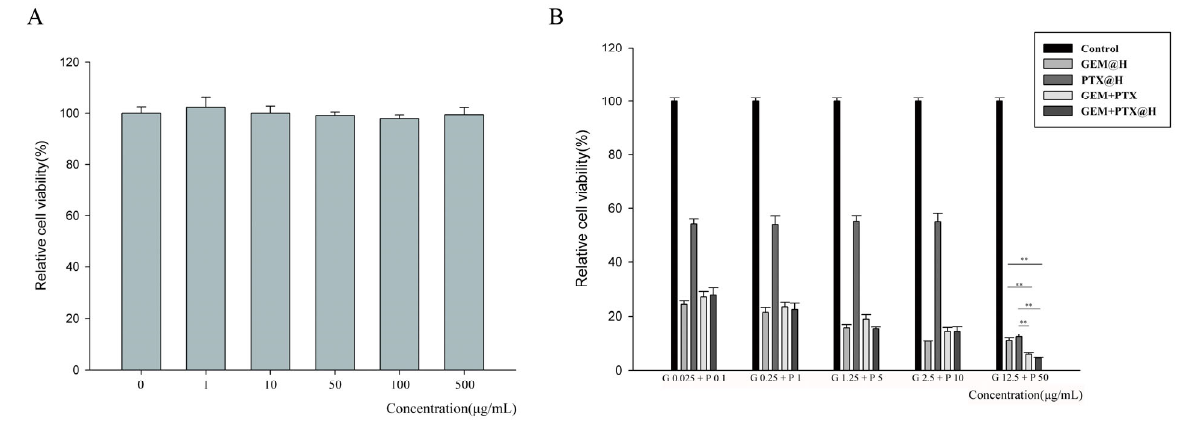
Figure 2. Cell viability of blank OE hydrogel ( A ). The cell inhibition rate of GEM-loaded OE pep- tide hydrogel, PTX-loaded OE peptide hydrogel, GEM+PTX-loaded OE peptide hydrogel and free GEM+PTX ( B ). ** p <